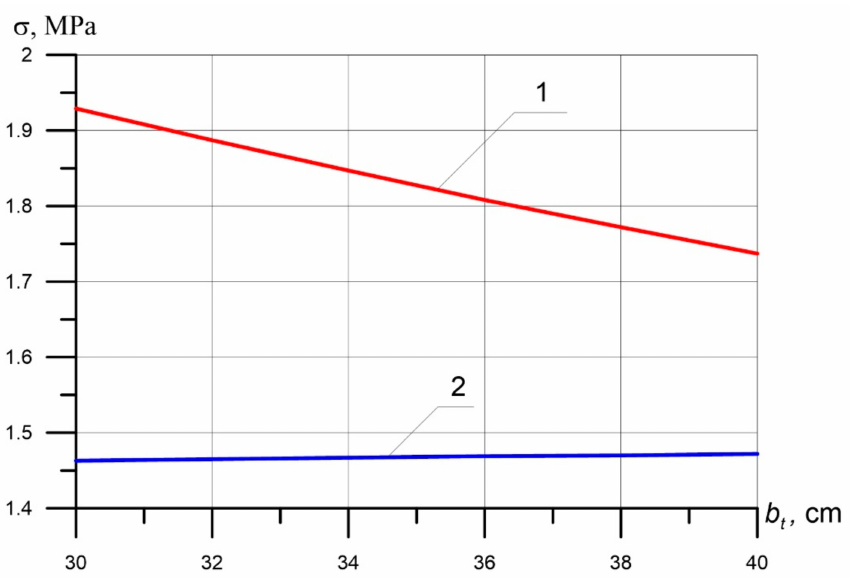
Figure 4. Dependences of dynamic stresses on the width of the I-beam flange b t in the tension zone without taking into account the mass of the fiber-reinforced concrete beam: ( 1 ) dynamic tensile stress; ( 2 ) dynamic compressive